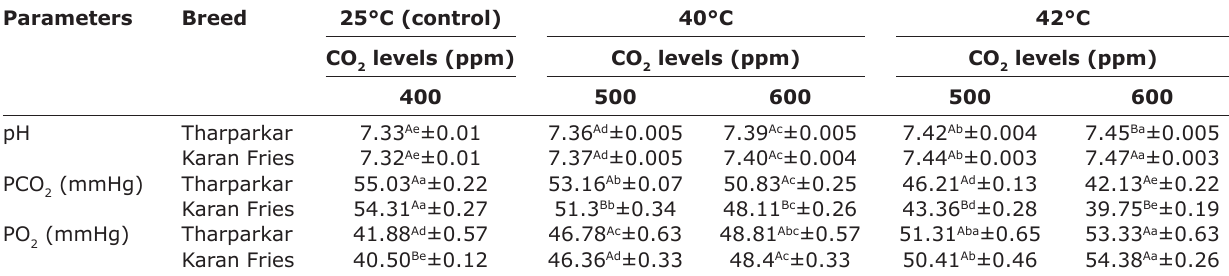
levels in on blood pH and blood gases of Tharparkar and Karan Fries 2